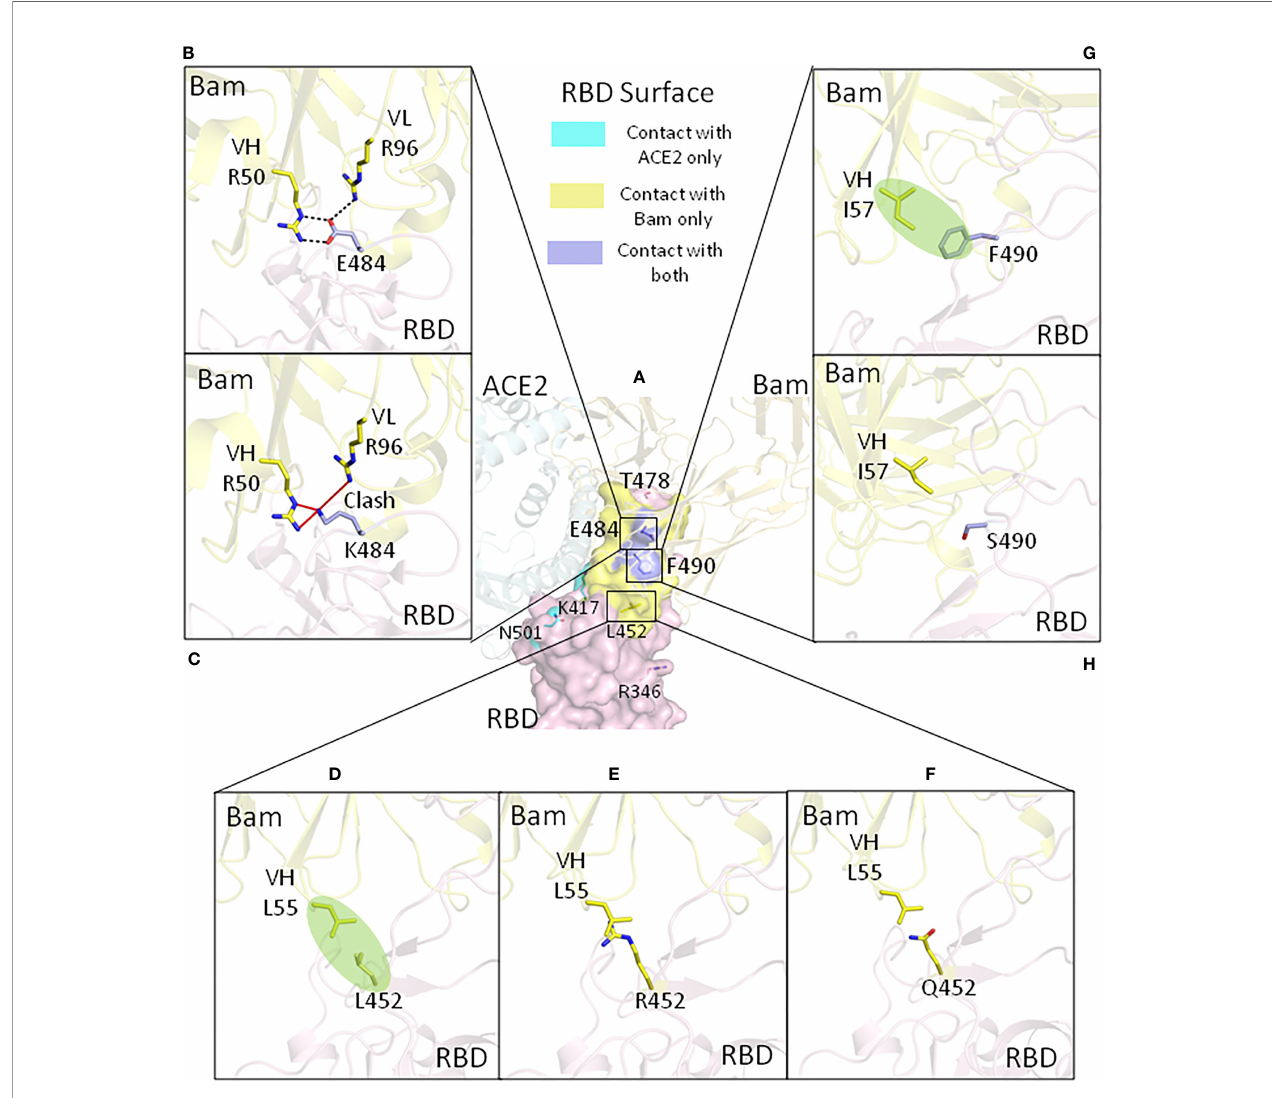
FIGURE 2 | The effect of the mutations of RBDs on interactions with bamlanivimab for currently identi fi ed SARS-CoV-2 VOC and VOI (with the exception of the Omicron variant). (A) The amino acids which have been mutated in the variants are shown on the ancestral RBD overlaying with ACE2 and bamlanivimab. Key ancestral and variant mutations that affect bamlanivimab af fi nity are shown in the following: (B) for ancestral glutamic acid 484, (C) for E484K mutation, (D) for ancestral leucine 452, (E) for L452R, (F) for L452Q mutation, (G) for ancestral phenylalanine 490, and (H) for F490S mutation. Bam, bamlanivimab. We used 7KMG (PDB ID) for bamlanivimab and RBD